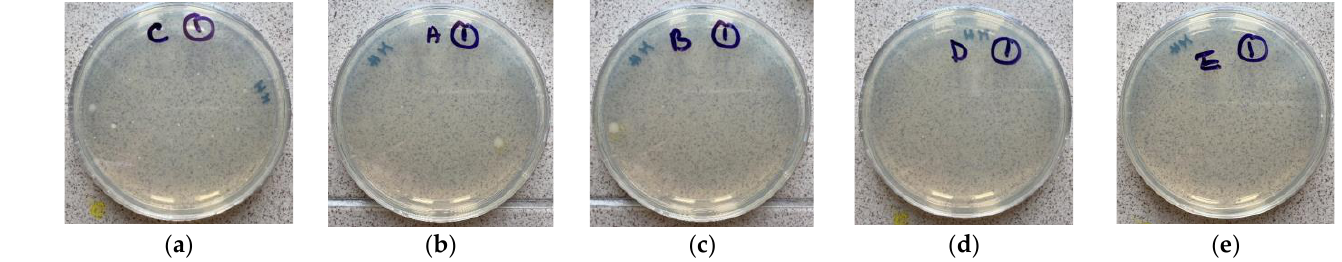
Figure 4. Microbial colonies after the disinfection with Zeta 7 Spray for each impression material: ( a ) Tropicalgin; ( b ) Zetaplus; ( c ) Oranwash L; ( d ) Elite HD + Putty Soft; ( e ) Elite HD + Light Body.